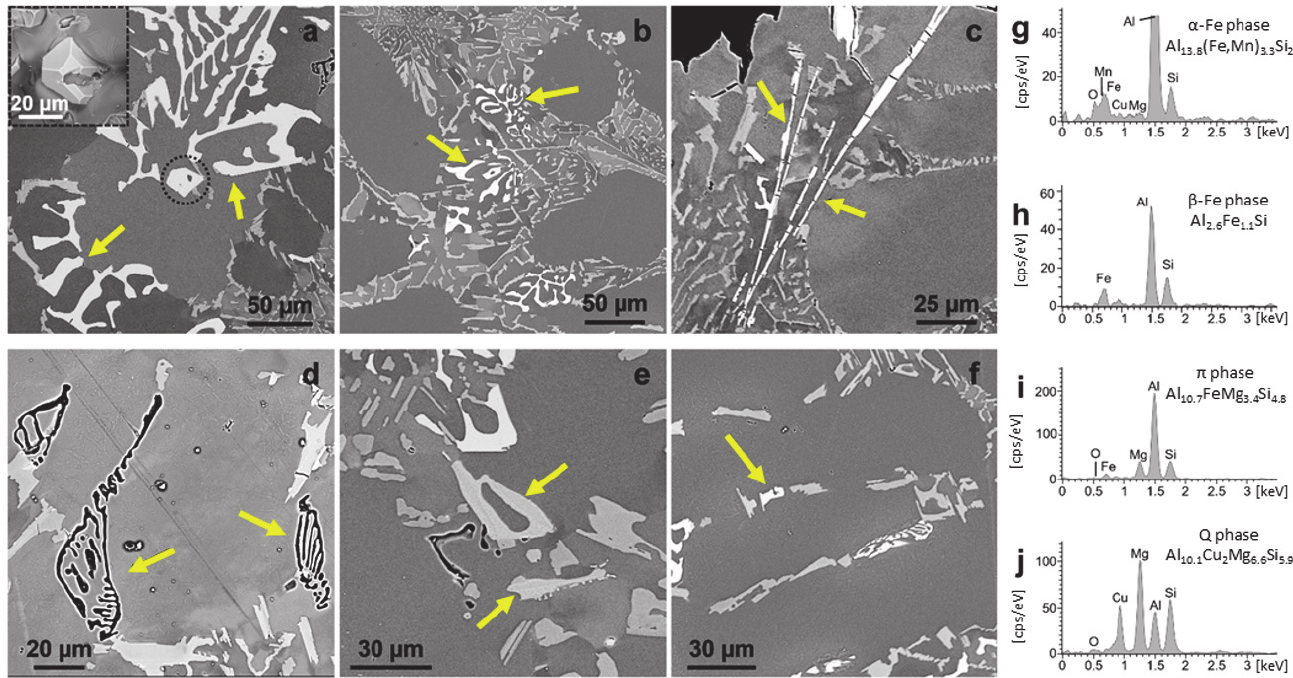
Figure 3: The intermetallic phases of the as-cast material observed through scanning electron microscopy with the energy dispersive X- ray analysis. The arrows indicate the intermetallics subjected to